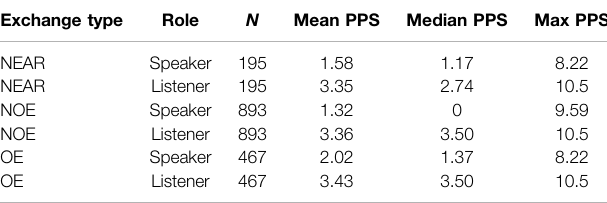
TABLE 5 | Turn Receipt Brow PPS summary statistics (pooled over